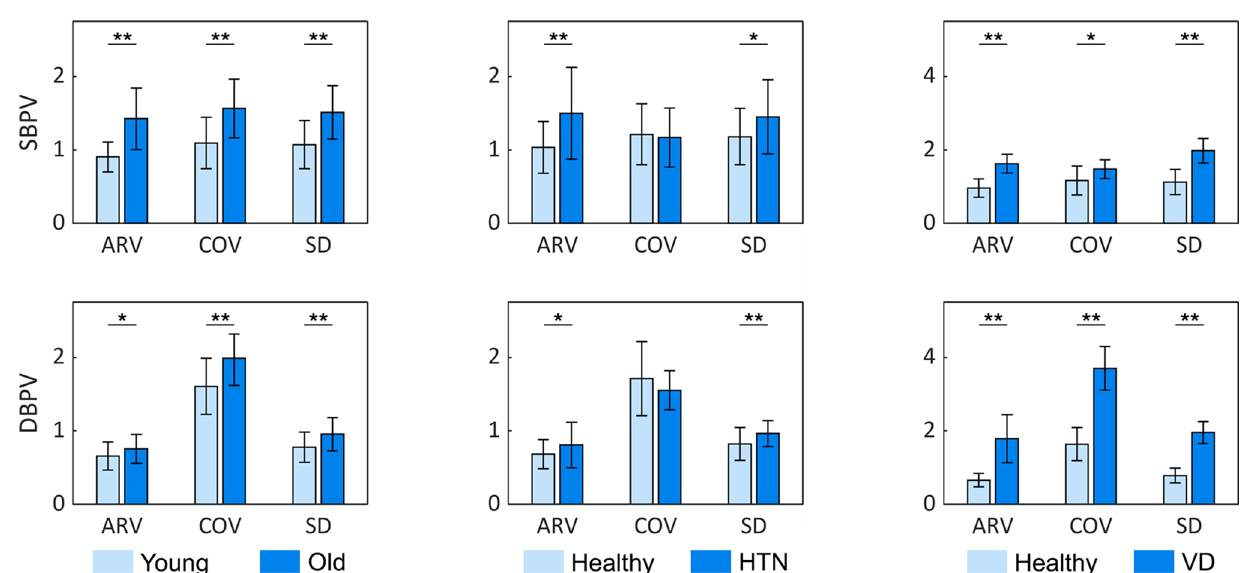
Figure 5. Associations between BPV and patient demographics. OR patients (n = 15) were stratified by age, history of hypertension (HTN), and history of vascular disease (VD). BPV was assessed using three metrics: standard deviation (SD), coefficient of variation (COV), and average real variability (ARV). *signifies p < 0.05; ** signifies p <